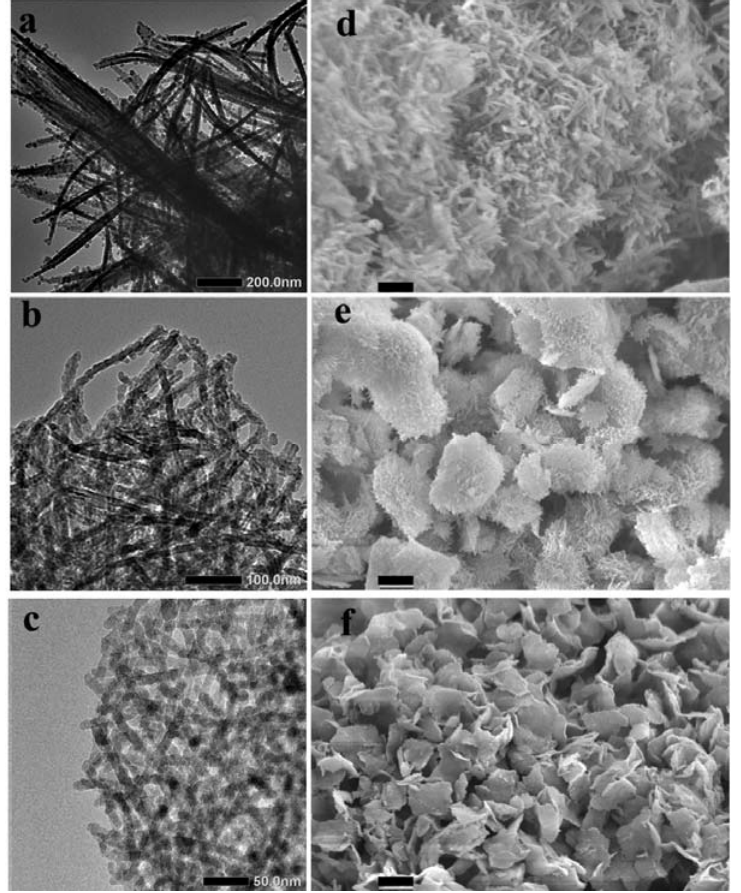
Figure 1. The transmission electron microscope (TEM) (left column) and scanning electron microscope (SEM) (right column) images of LPEI@SiO cooling processes by fixing 10 g of 2 wt % LPEI and 10 mL of 10 vol % MS-51. From up increased from 4, to 10, to 25 g, and corresponded to Process-I, -II, -III, row to bottom one, m ice